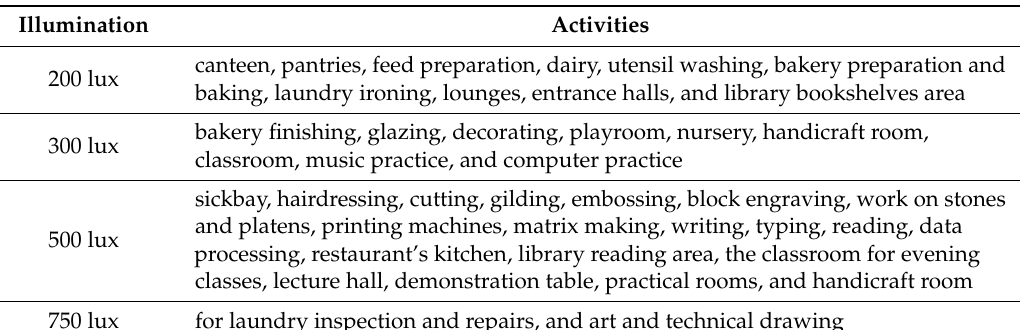
Table 1. Illumination standards mentioned in BS EN 12464-1:2011